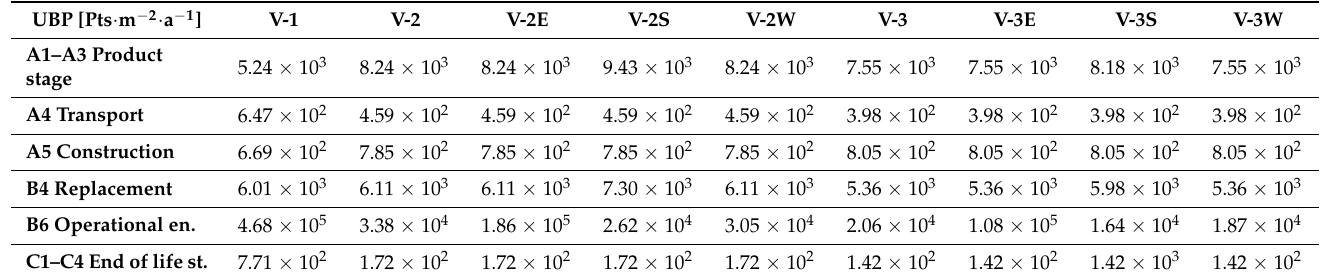
Table 3. Overall environmental impacts (OEIs) of individual variants of the house per 1 m 2 of treated floor area (TFA) and year of operation in relevant LCA stages and modules, according to EN 15978.